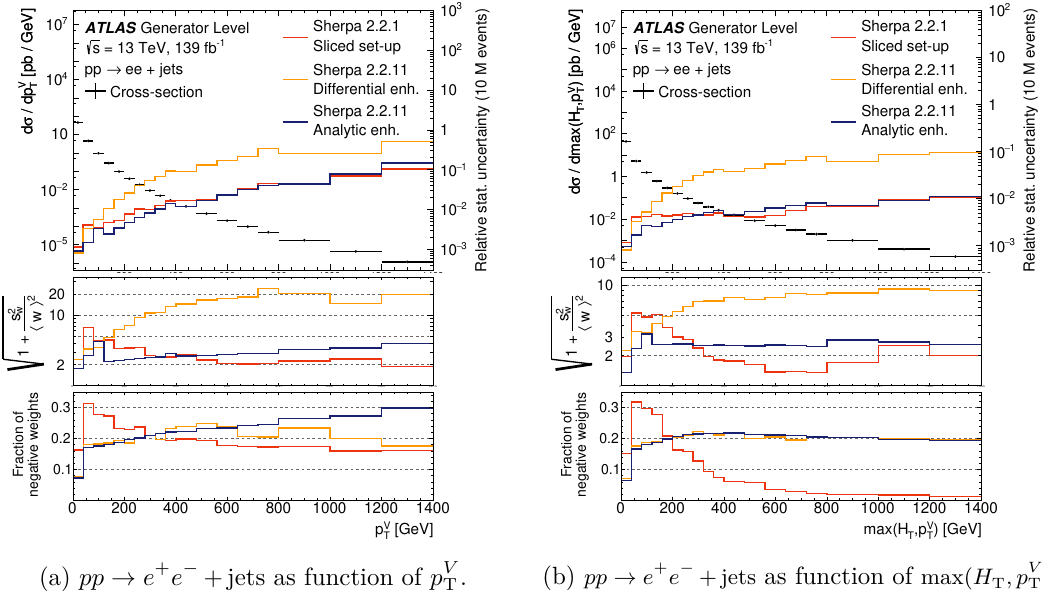
Figure 13 . Differential cross-section of pp → e + e − + jets as a function of (a) p V max ( H ) in black, as read from the left axis. The relative differential uncertainty of said cross- , p V T T section for the three enhancement schemes is shown superimposed and should be read from the right axis. The first panel shows the differential efficiency factor resulting from the weight spread, whilst the second panel shows the negative-weight fraction, as a function of p V subdomain sampling capability of the sliced enhancement strategy is still invaluable.